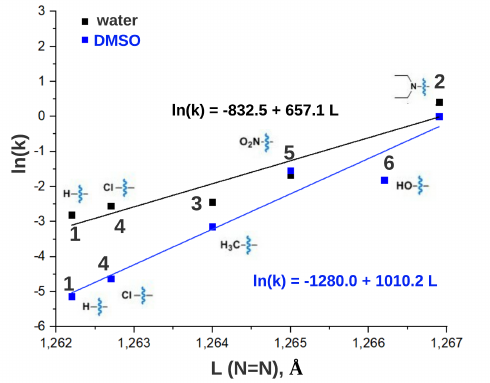
Figure 9. The dependence of the logarithm of thermal isomerization kinetic constant of Z ATPLs (ln(k)) on the Hammett constants of substituents ( σ ) in DMSO ( 1 ) and water ( 2 ). The values of thermal lifetimes of Z forms are also given in the figure. The dependencies were approximated by linear functions for σ > 0 and σ < 0 separately. Parameters of approximations are given in the figure.